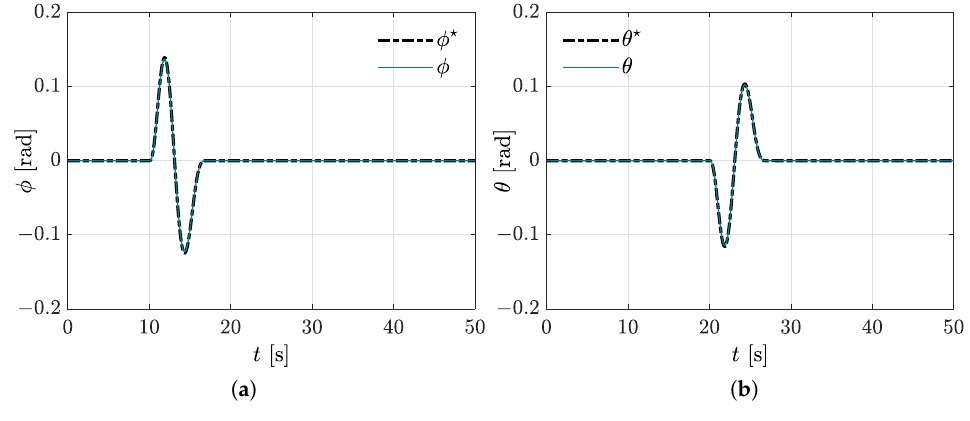
Figure 4. Tracking of the online computed desired angles. ( a ) Desired roll angle tracking. ( b ) Desired pitch angle tracking.